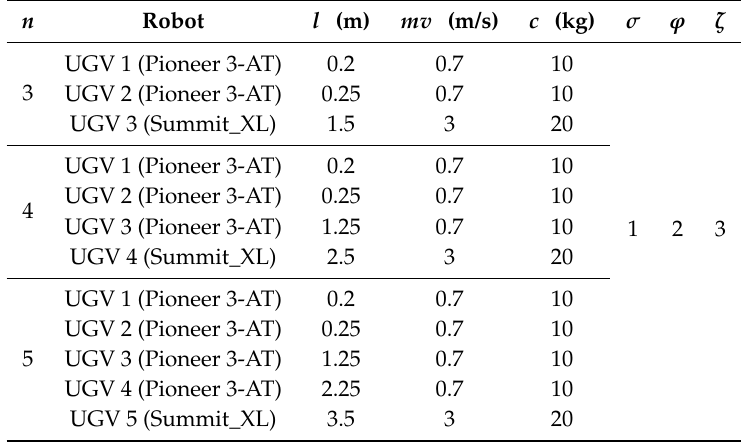
Table 1. Specifications of heterogeneous robots and gain coefficients used in the simulation. n